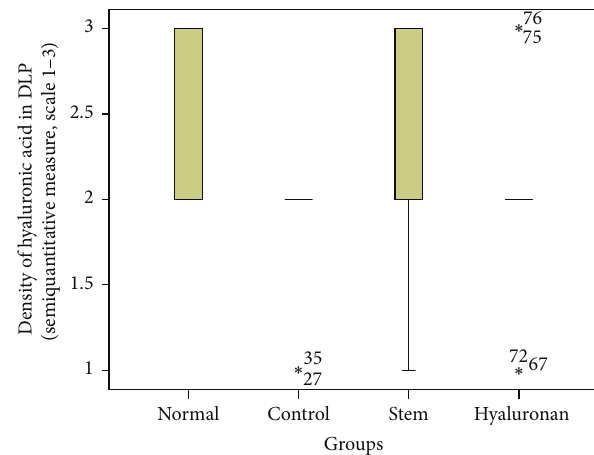
Figure 23: Density of hyaluronic acid in the deep lamina propria (DLP). Normal = normal/control group, control = scarred/control group, stem = stem cell group, and hyaluronan = hyaluronan